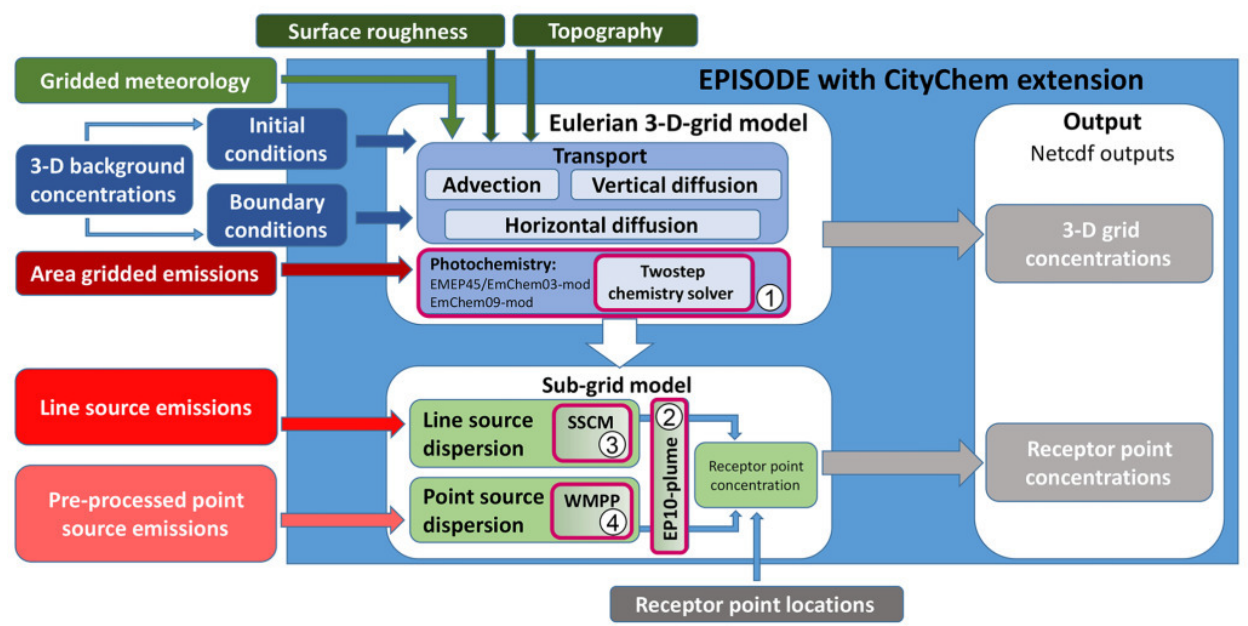
Figure 8. Schematic diagram of the EPISODE model with the CityChem extension (EPISODE–CityChem model), from Karl et al. (2019b).